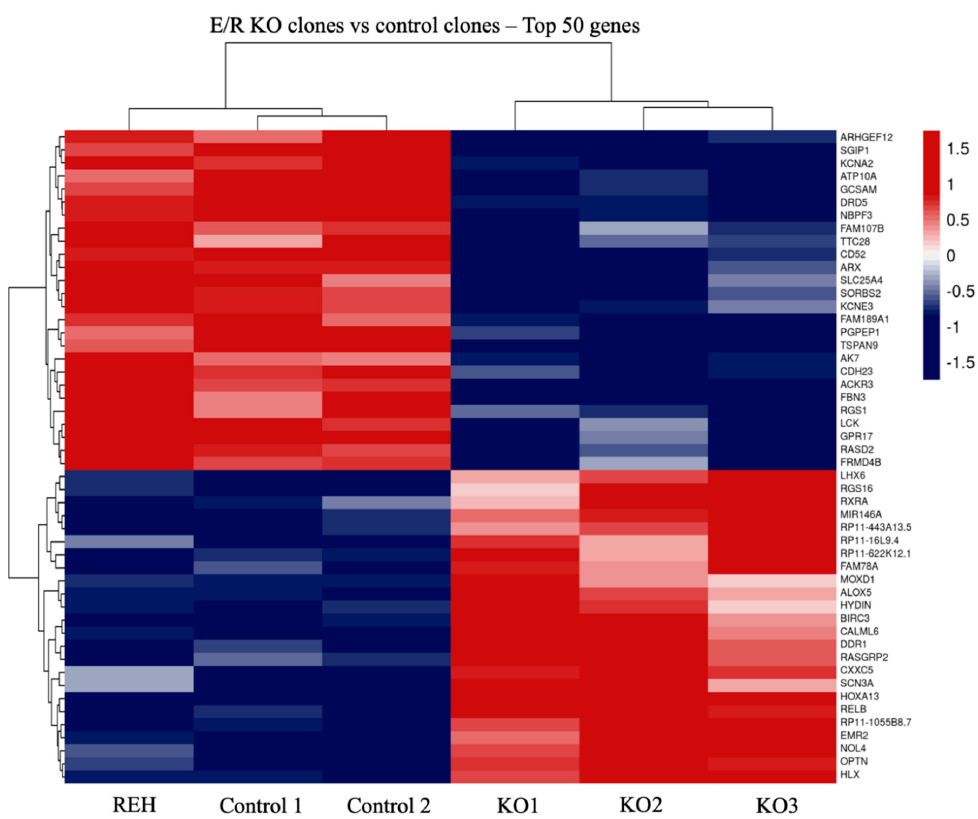
Figure 2. Transcriptomic analysis of E / R KO clones. Heat map of TOP50 di ff erentially expressed genes in E / R Knock-out (KO) clones as compared with REH cells and control clones. Each row represents one di ff erentially expressed gene; each column represents one clone. The dendrogram on the top reveals the sample clustering; the dendrogram on the left reveals the gene clustering.